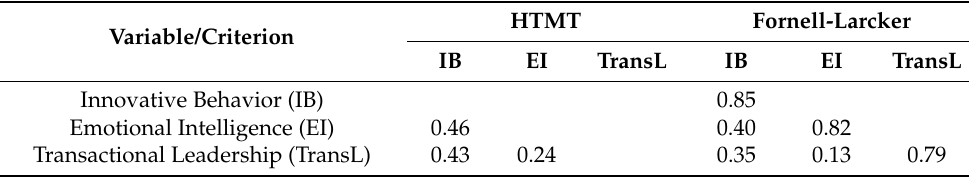
Table 2. Fornell and Larcker criterion to assess discriminant